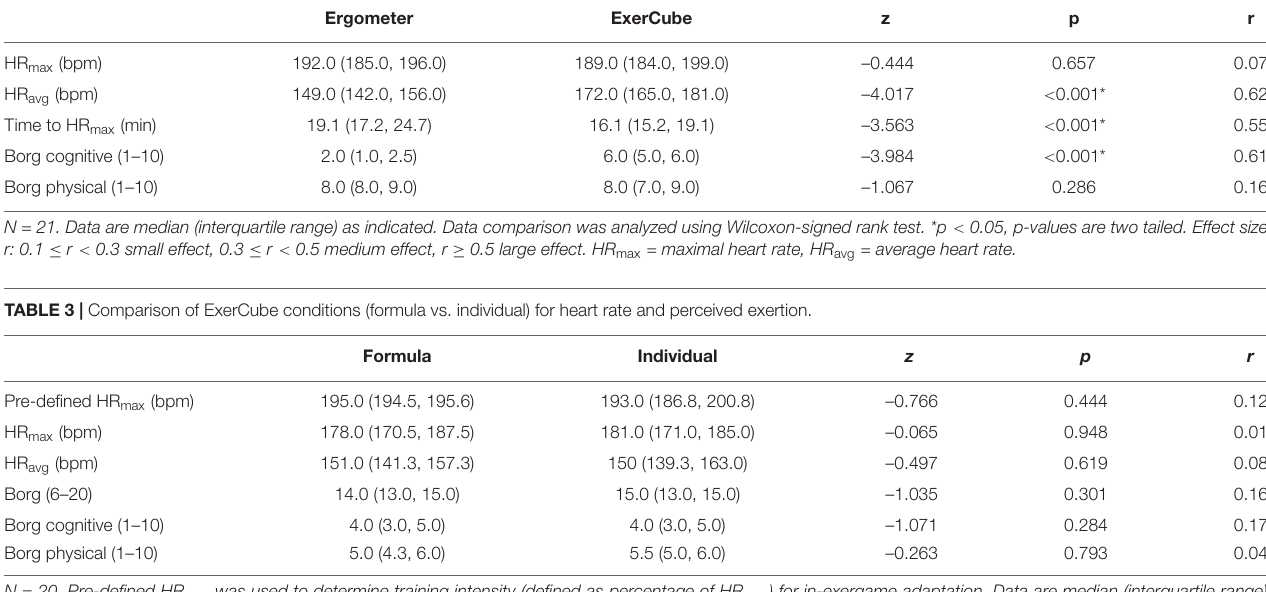
TABLE 2 | Comparison of maximal heart rate testing.